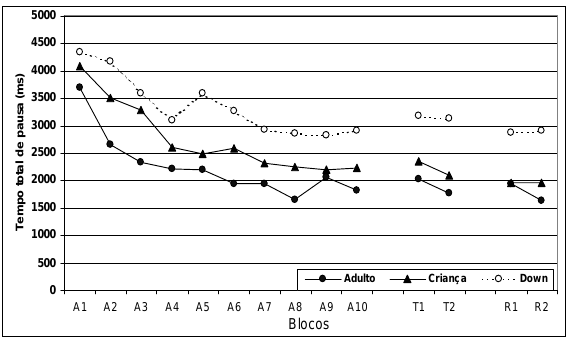
Figura 3 . Mediana do tempo total de pausa ao longo das fases para os três 012345678910